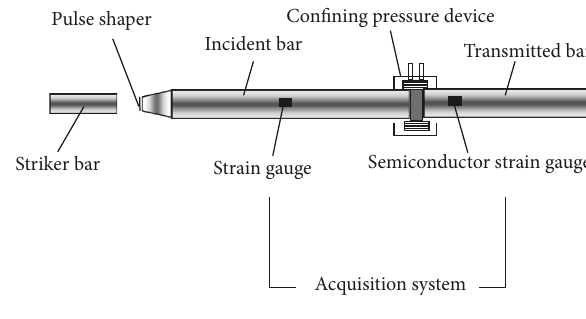
Figure 1: Split Hopkinson pressure bar.